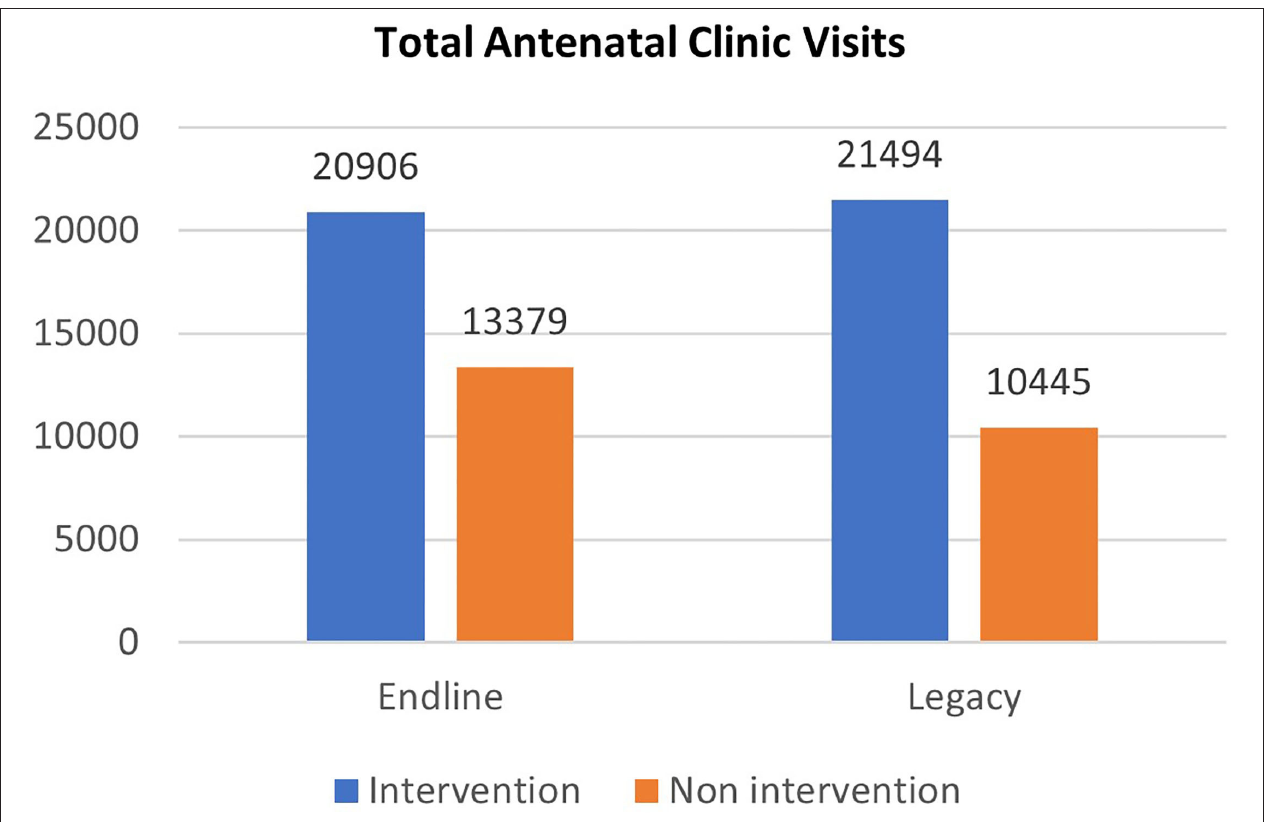
FIGURE 3 | Antenatal clinic visit across two phases of